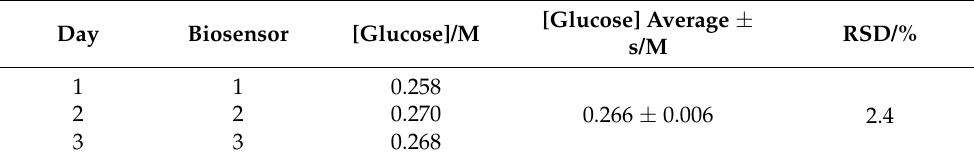
Table 6. Study of the system robustness. Measurements were performed on three different days